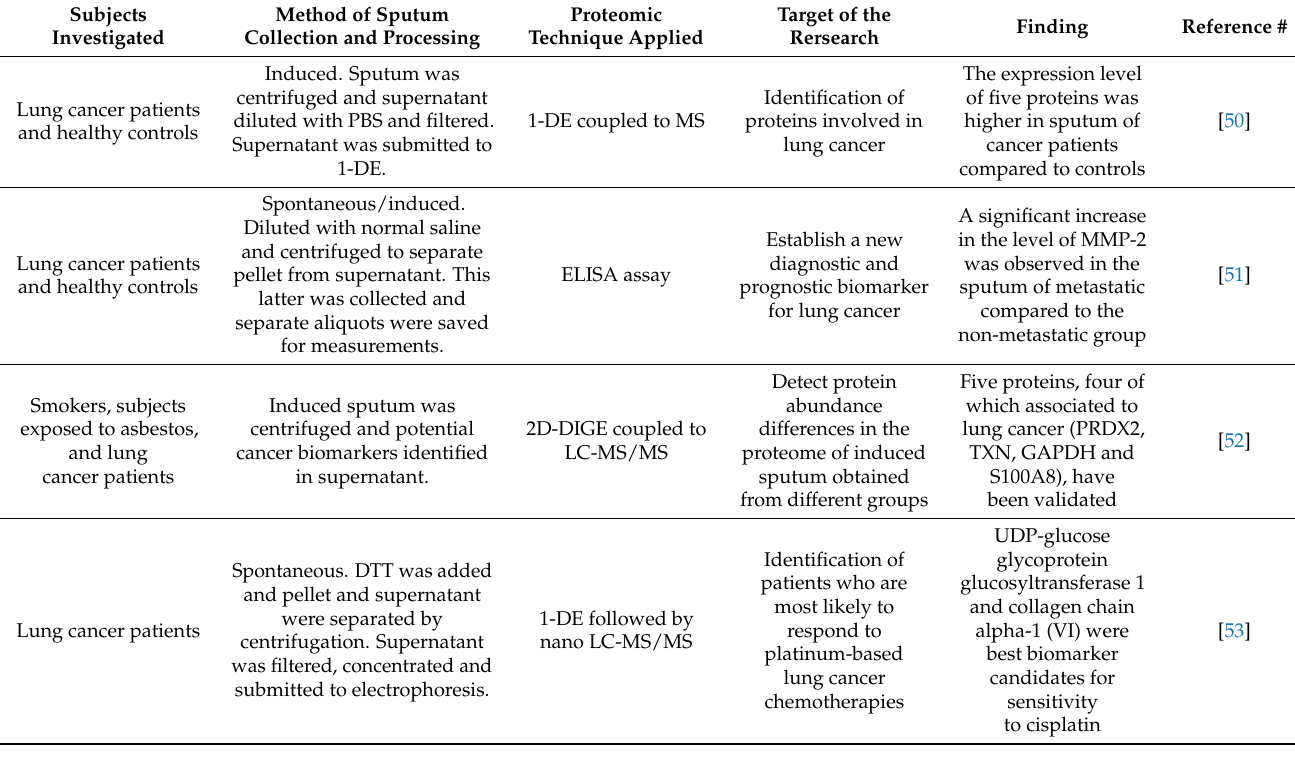
Table 5. List of articles dealing with proteomics of sputum in patients with lung